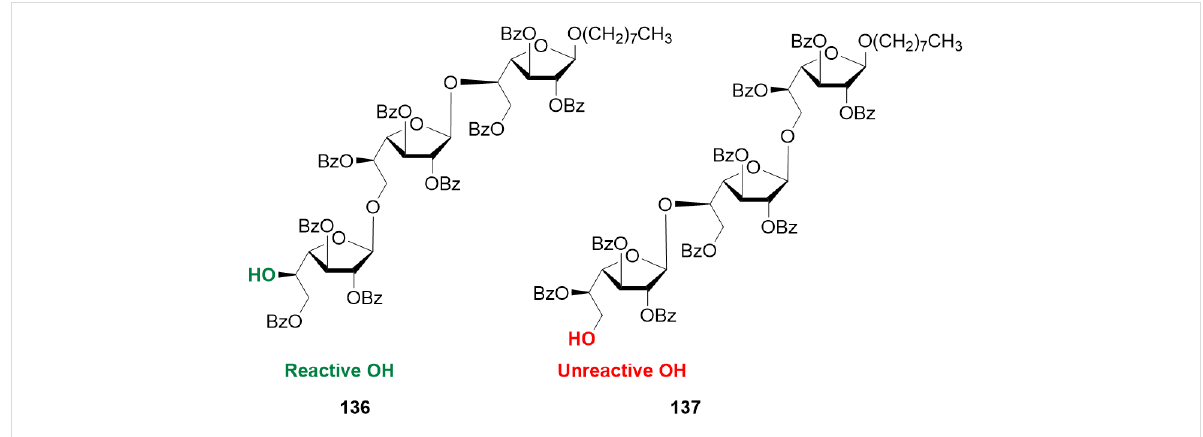
Figure 14: The poor reactivity of acceptor 137 hindered a stepwise synthesis of the linear galactan backbone at the 3mer stage. In contrast, acceptor 136 proved to be more reactive.